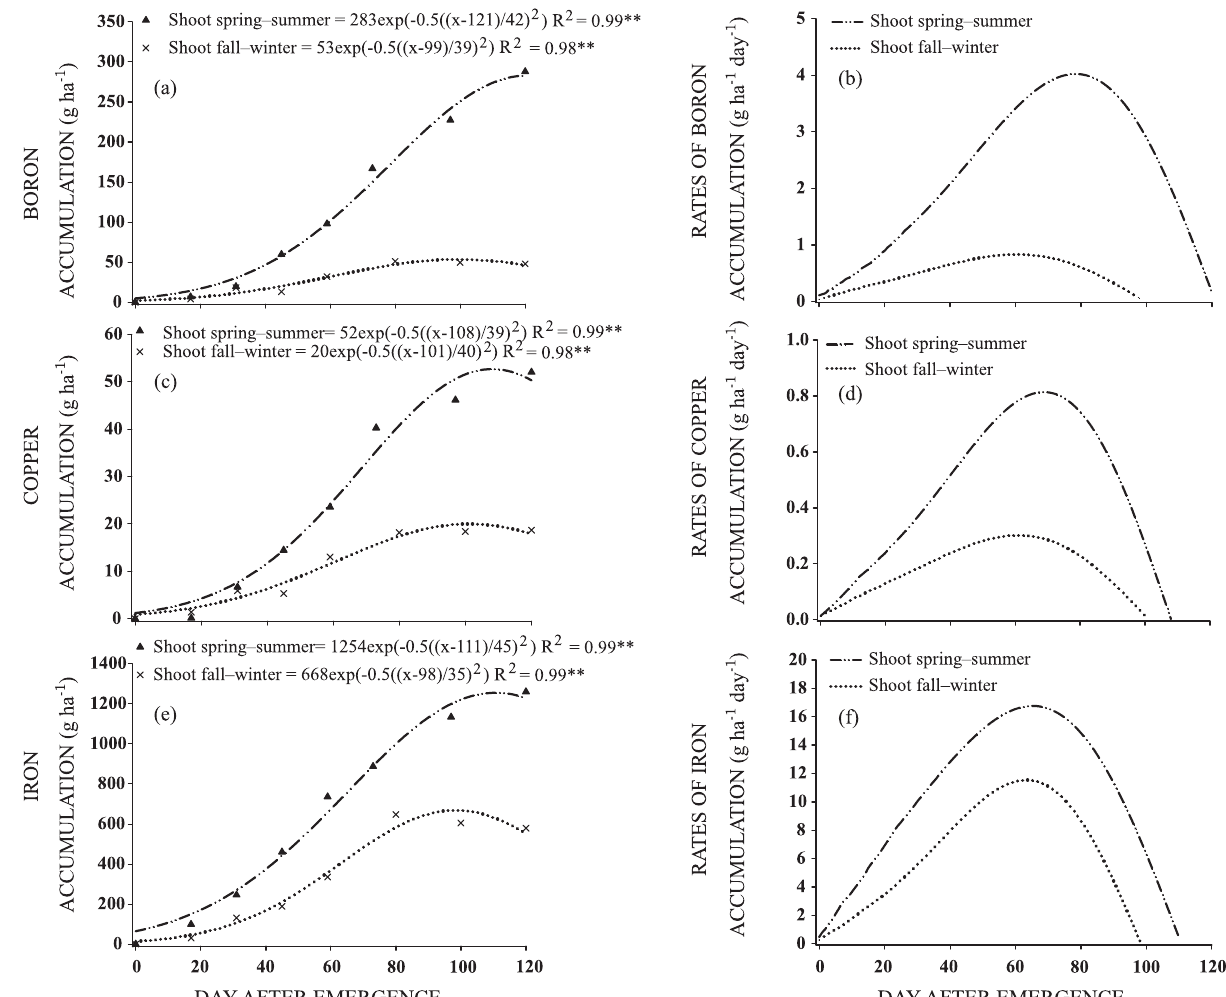
Figure 5. accumulation and accumulation rates of boron (a and b), copper (c and d) and iron (e and f) in shoot of the castor bean hybrid Lyra in the 2005/2006 spring-summer and 2006 fall-winter growing seasons. **: significant at p ≤ 0.01 by the F